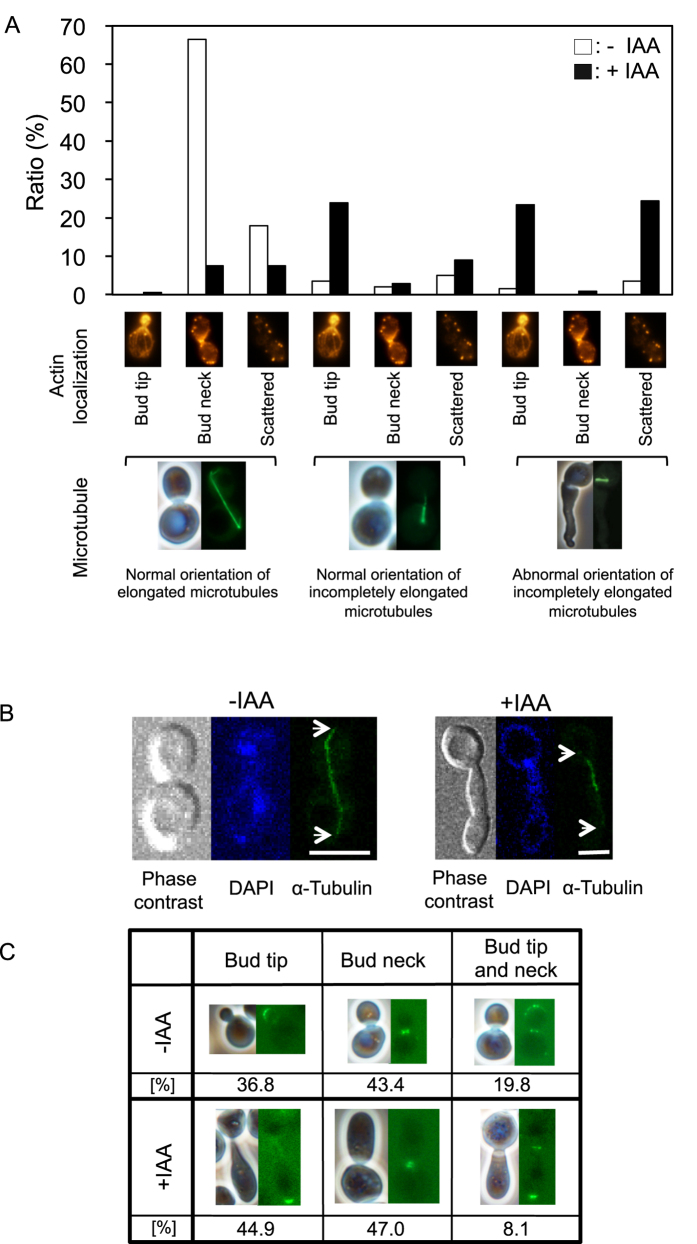
Localization of microtubules and actin during cell elongation.(A) BY23323 cells were incubated with (+IAA) or without (-IAA) 0.25% IAA. Microtubules and actin were visualized based on fluorescence derived from Tub1-GFP and rhodamine-phalloidin staining, respectively. More than 200 cells were randomly selected from daughter cells that had grown sufficiently big in the control treatment or from elongated cells in IAA treatment. The selected cells were observed and classified. Actin: left, actin patches were observed at the bud tip; centre, actin ring was formed at the bud neck; right, actin patches were scattered throughout the cytoplasm. Microtubules: left, normal orientation of elongated microtubules; centre, normal orientation of incompletely elongated microtubules; right, abnormal orientation of incompletely elongated microtubules. (B) BY23323 cells incubated with (+IAA) or without (-IAA) 0.25% IAA for 8 h were scanned in 11 steps with 0.5-μm step size. DNA was stained with DAPI. Arrows indicate the plus ends of microtubules. Bars, 4 μm. (C) EY0986/GFP-Bud6 cells were incubated with (+IAA) or without (-IAA) 0.5% IAA for 8 h. Bud6 was visualized based on fluorescence derived from GFP-Bud6. More than 200 cells randomly selected from budded cells in control treatment or from elongated cells in treatment with IAA were observed and classified.